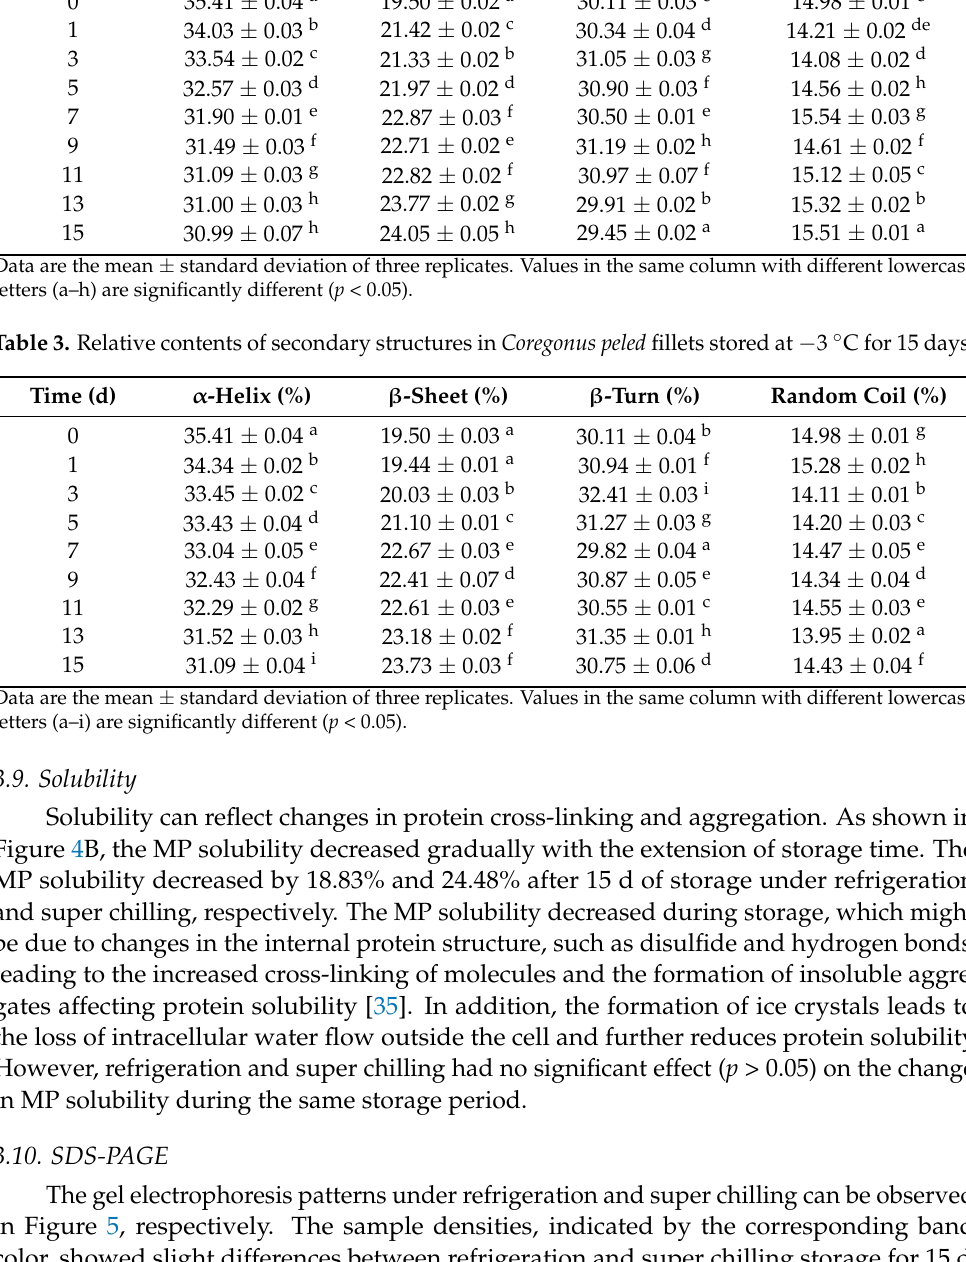
Table 2. Relative contents of secondary structures in Coregonus peled fillets stored at 4 ◦ C for 15 days. Time (d)